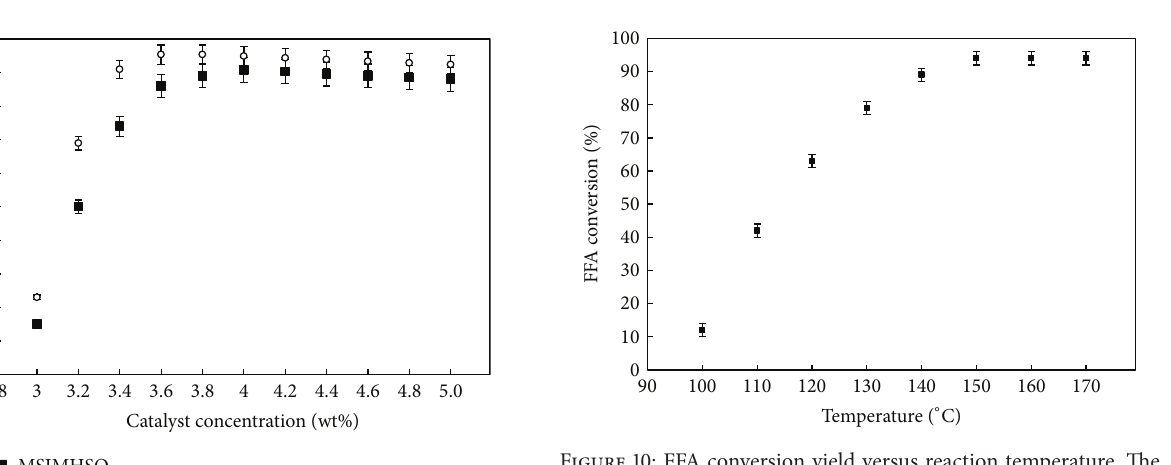
Figure 10: FFA conversion yield versus reaction temperature. The reaction conditions were 12 :1 methanol/CCO molar ratio, 3.6 wt% DSIMHSO 4 , and 600 rpm for 3h.